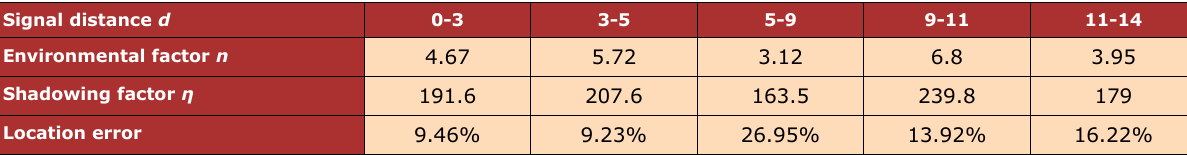
Table 1. Fitting model in short